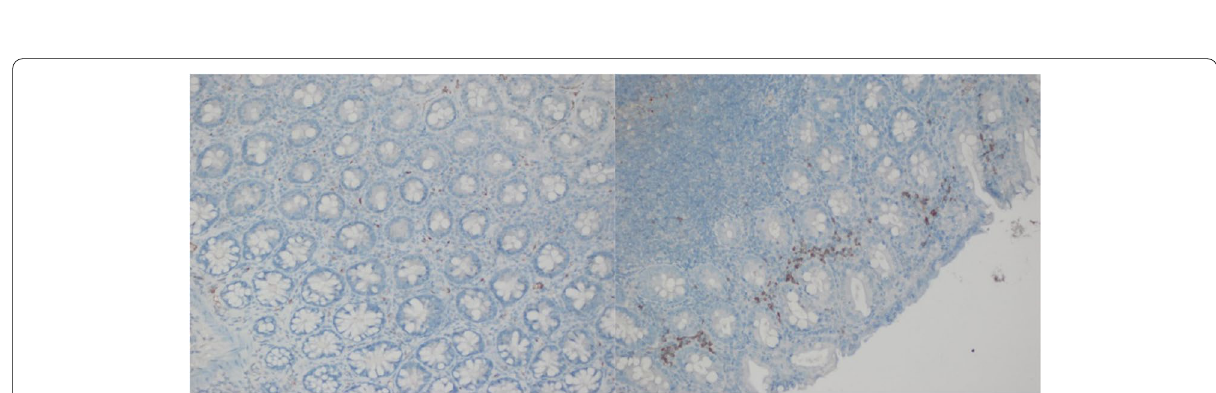
Fig. 2 TNF-α antibody, 20. Expression in clustered cells in the lamina propria was expressed as × evaluated as